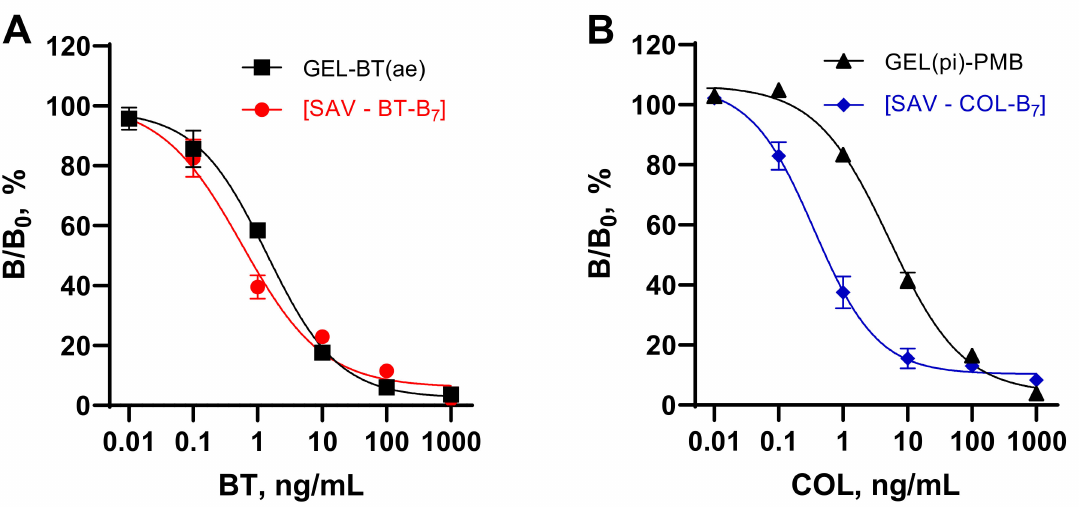
Figure 3. Competitive ELISAs for bacitracin ( A ) and colistin ( B ) based on hapten–protein conjugates (empty symbols) and complexes formed between streptavidin (SAV) and biotinylated (B 7 ) hapten (filled